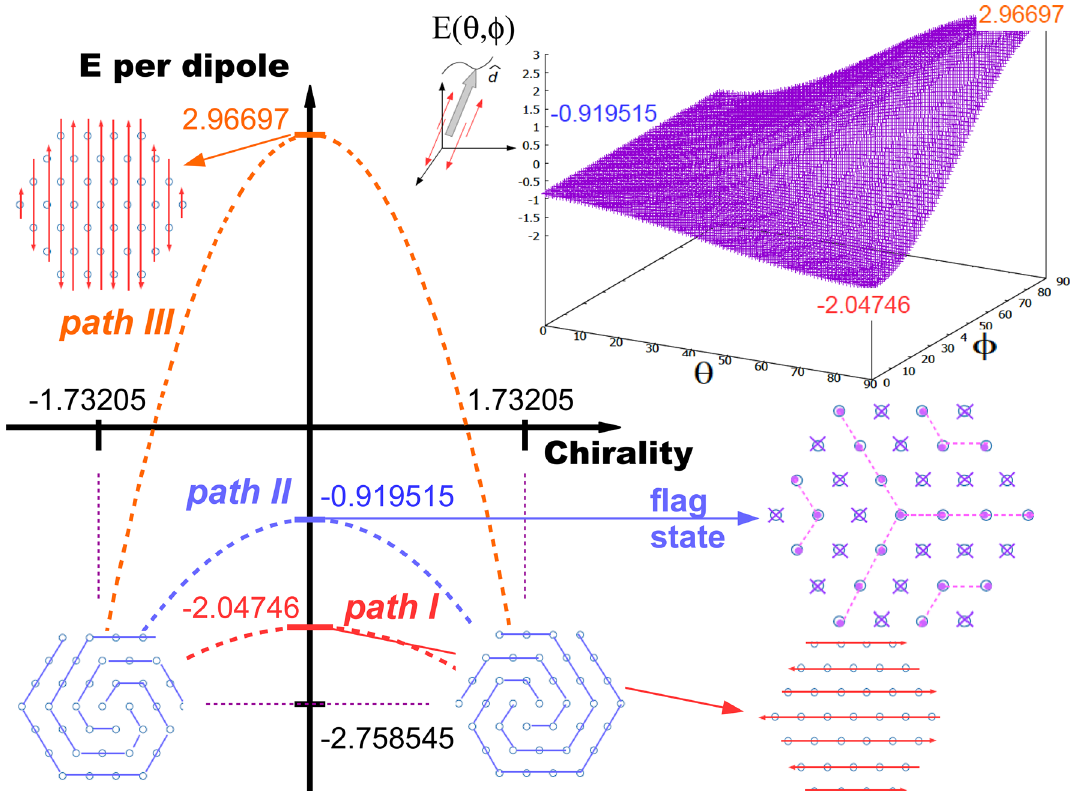
Figure 4. Plot of the different paths that can lead to the appearance of the vortex ground state by virtue a spontaneous symmetry breaking mechanism. The role of the order parameter is played by the chirality. All states shown except the vortex can be topologically connected by the same transformation shown next to the corresponding energy landscape. Remarkably, the energy of the flag state is exactly one-third of the energy of the vortex one. See text for